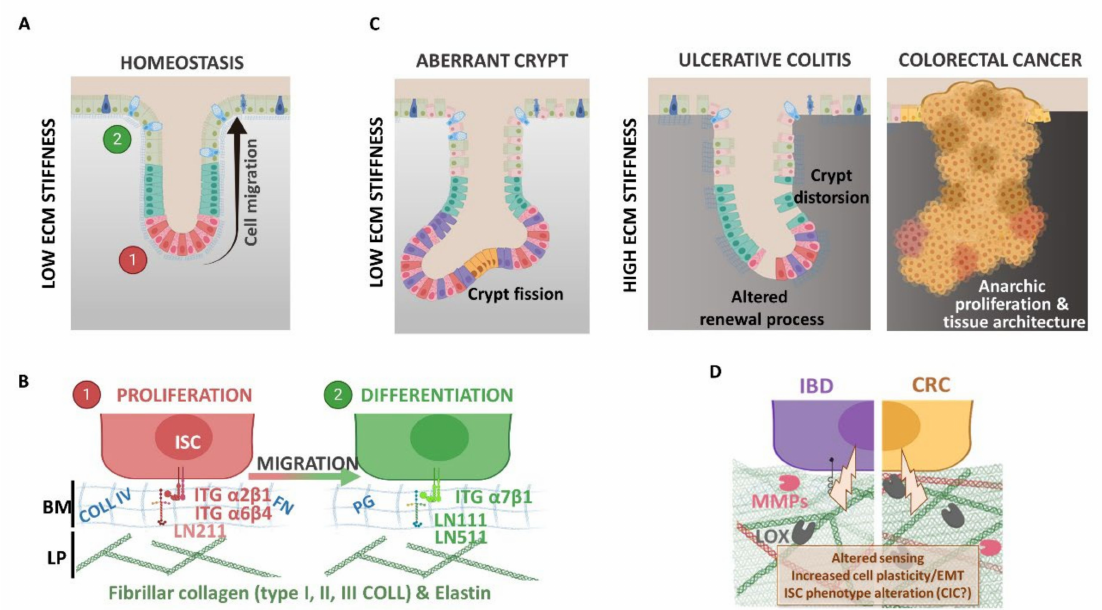
Figure 2. ( A , B ) Extracellular matrix (ECM) and epithelial cell phenotype regulation under physiological context. Colonic epithelial cells interact with the basement membrane (BM) composed of collagen type IV (COLL IV), fibronectin (FN), several proteoglycan (PG) and laminin (LN) subtypes. The BM allows epithelial cell migration from proliferating to di ff erentiating compartments along the crypt axis. Di ff erent LN isoforms are expressed in these two compartments: LN211 is expressed at the crypt bottom near the proliferative cells (ISC and TA cells), whereas LN111 and LN511 are mainly found within the di ff erentiation compartment. The di ff erentiated cells sense ECM components with di ff erent integrin (ITG) isoforms. ( C , D ) Extracellular matrix (ECM) and altered epithelium contexts. In the aberrant crypt or during inflammatory bowel disease (IBD) and colorectal cancer (CRC), the epithelium displays several alterations, like a tissue architecture deformation (i.e., crypt fission or distortion), and increases the ECM rigidity support (inflammation and cancer). In fact, the ECM network undergoes high remodeling during pathology compared to physiology: (i) increased fibrillar collagen deposition (COLL I and III) and crosslinking via lysyl oxidase enzymes (LOX) that modify colonic tissue sti ff ness and (ii) basement membrane disruption and ECM free fragments releasing due to metalloproteinase degradation (MMP, like MMP2 and MMP9). ECM processing a ff ects epithelial cell behaviors like proliferation, stemness, epithelia-mesenchymal transition (EMT) or survival, contributing to disease progression and favoring cancer-initiating cell (CIC)